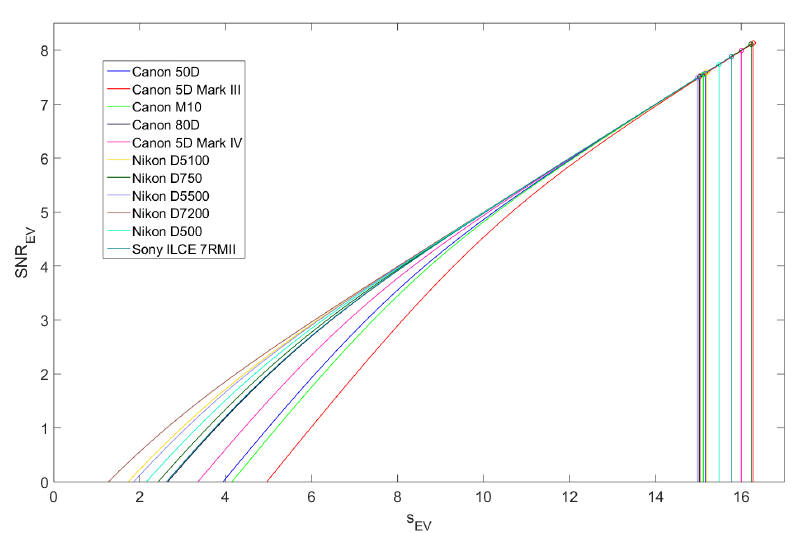
Figure 9. Pixel SNR vs. number of electrons for ISO